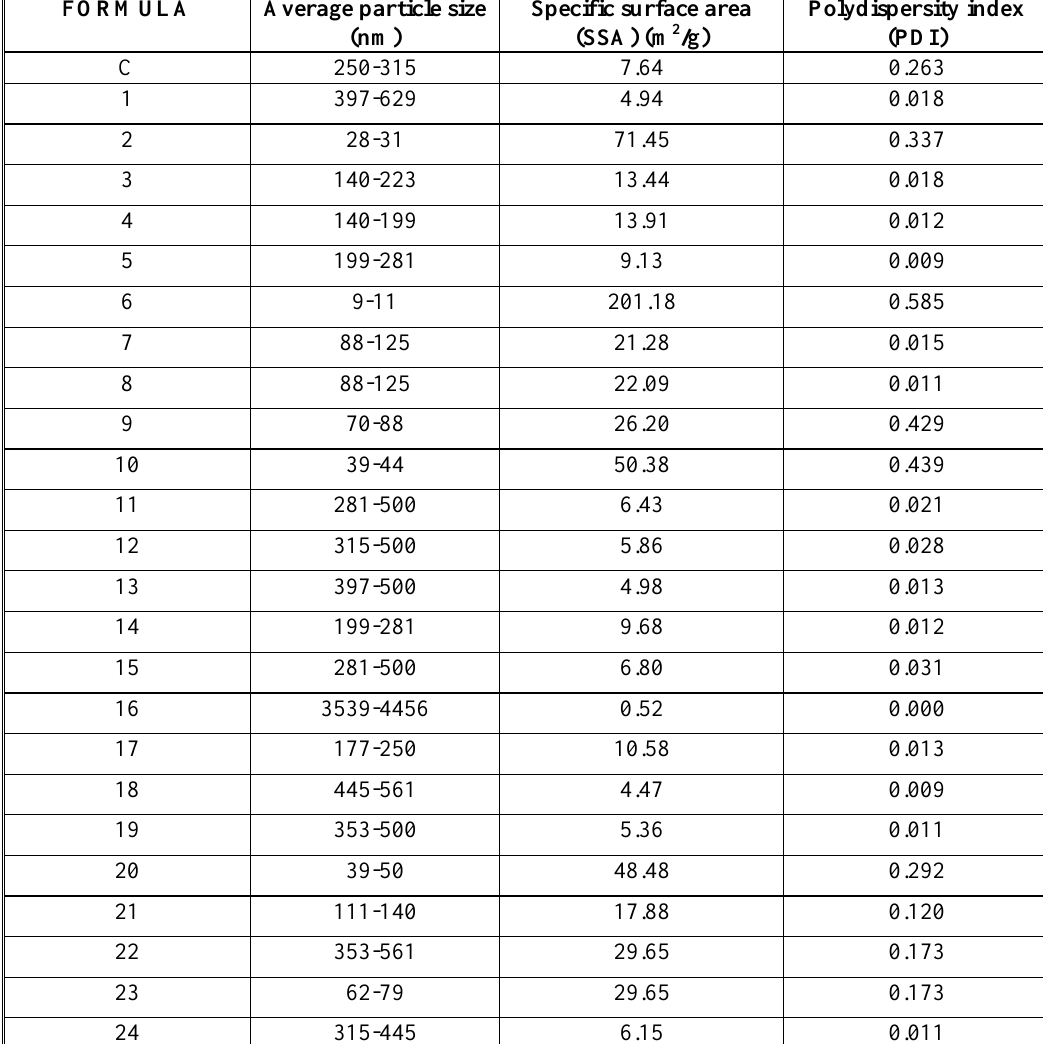
Table (2): Particle size, specific surface area and polydispersity index results of various